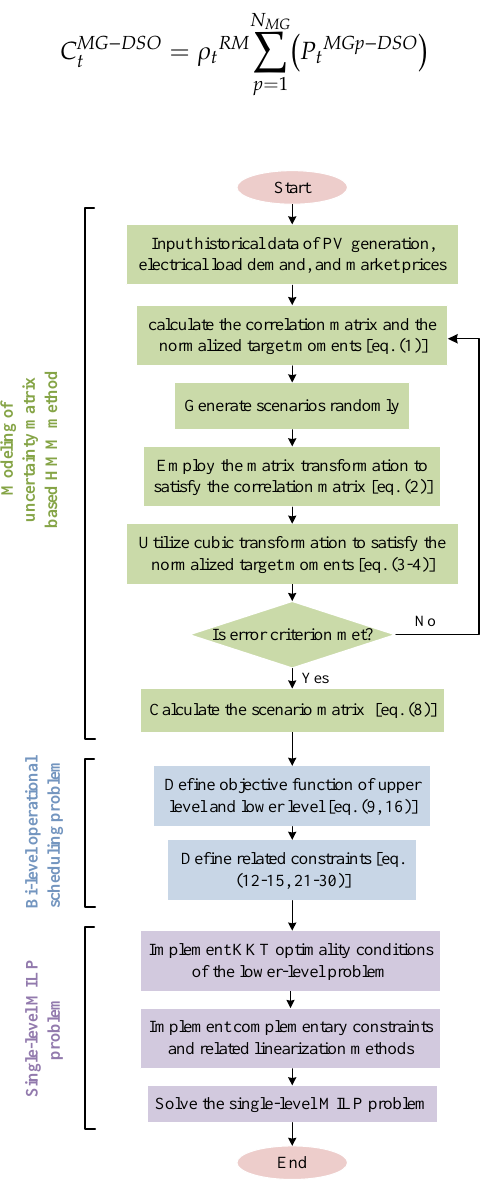
Figure 2. The framework of the proposed bi-level optimization model.